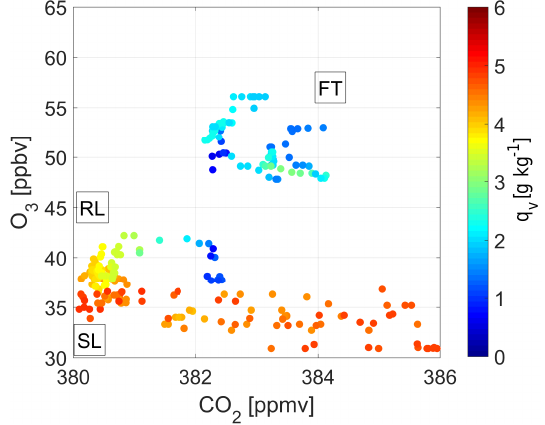
Figure 9. Correlations between CO 2 and O 3 during the observa- tions at 07:27UTC colour-coded according to specific humidity measurements. The aircraft descended from the FT into the PBL, indicated by a clear separation from the chemical signature.